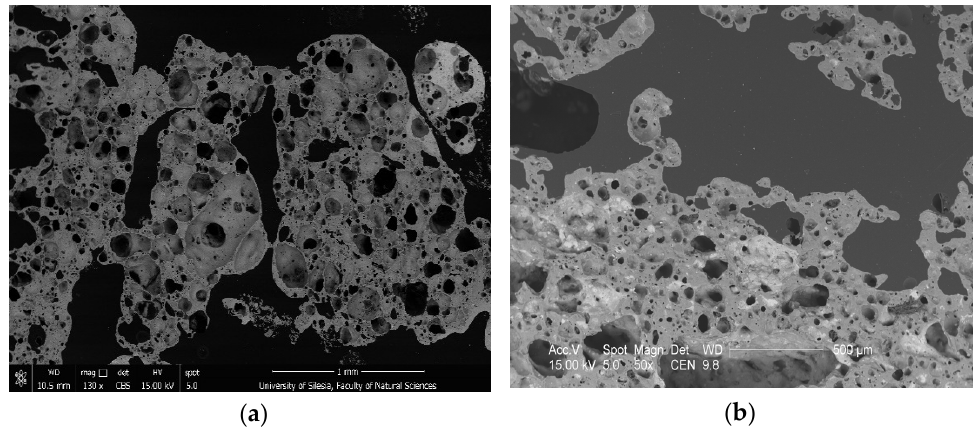
Figure 3. SEM images of sinter found in ash from coal combustion in individual domestic furnaces: ( a ) ash from eco-pea coal; ( b ) ash from hard coal. Sintered ash in a class 5 boiler burning eco-pea coal can be problematic due to its negative impact on the hearth and thus the amount of generated heat. It is also indicative of eco-pea being of inferior quality. Sinters are found in class 4 furnaces because the